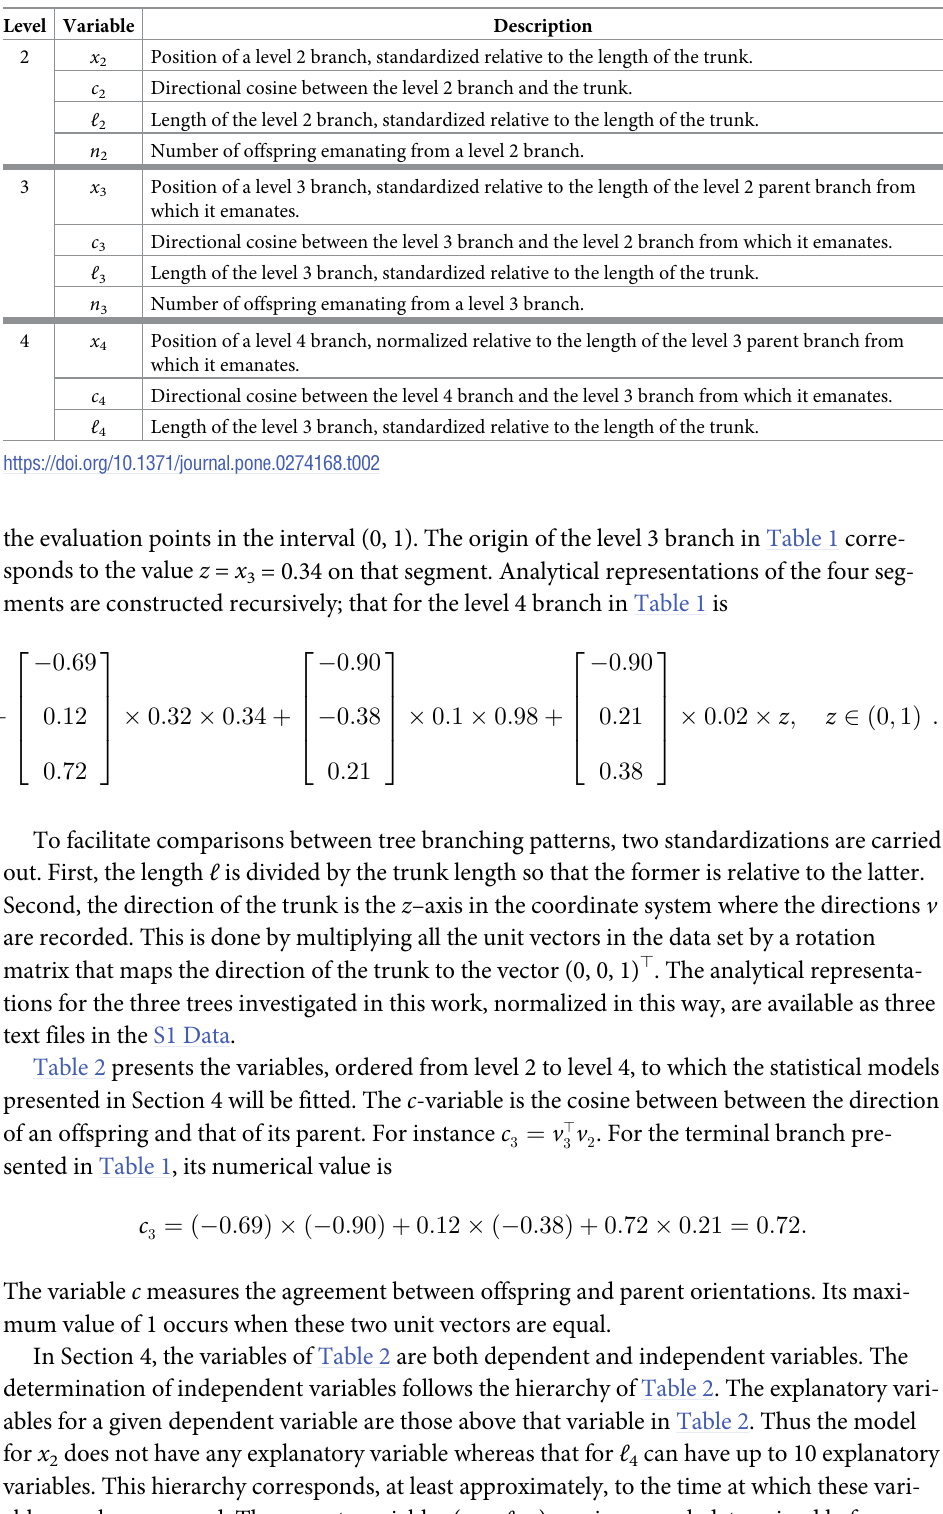
Table 2. Description of the variables used in Section